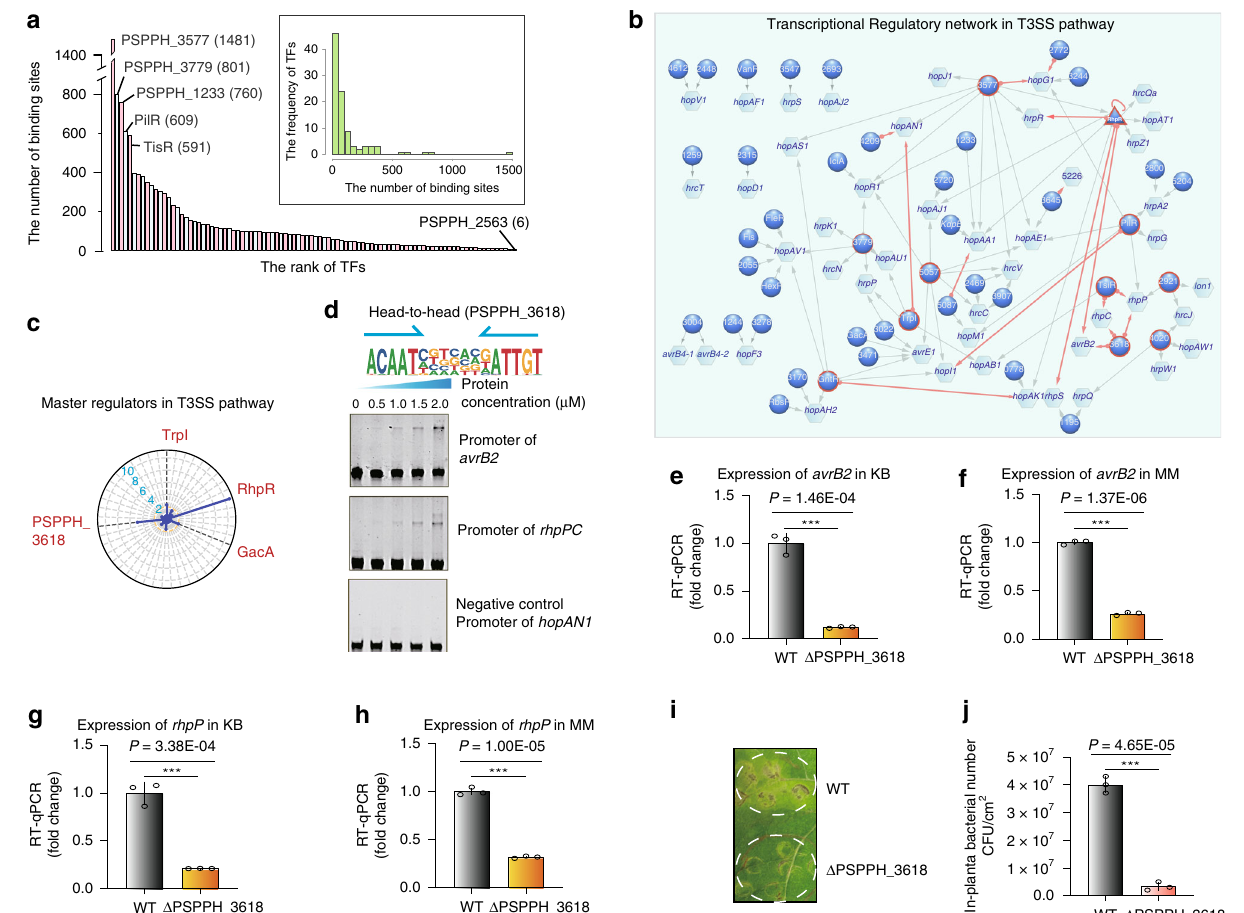
Fig. 3 Transcriptional regulation in the T3SS pathway. a Bar chart shows the distribution on the number of the putative binding sites per TF. Note that most of TFs target fewer than 200 genes with fi ve TFs exceptional bind more than 500 sites in the genome. b Network illustrates the regulatory relationship between TFs and their target genes in the T3SS pathway. Circles indicate TF proteins, hexagons indicate target genes, and the triangle represents the TF with auto-regulatory activity. TFs that can regulate more than two target genes are highlighted by the red edges. Red arrows show the putative binding sites located in the promoters of the target genes, while gray arrows show the putative binding sites located in the target gene bodies. The TFs without names are named with their locus tag omitting PSPPH_. c Radar plot shows the putative master regulators identi fi ed in the T3SS pathway. Each radiation line represents a TF, and the radial length of thick colored line is − log10 ( P value), representing the signi fi cance of the enrichment of the TF targets within T3SS-associated genes. The names of master regulators are marked in red-type face. d The head-to-head binding motif of PSPPH_3618 (upper) and the validation of the putative binding sites of PSPPH_3618 by EMSA (lower). The validated binding sites were from the promoters of the rhpPC operon and avrB2 . The promoter of hopAN1 was negative control. e , f The expression of target gene avrB2 was measured in the WT and Δ PSPPH_3618 strains by RT-qPCR in KB and MM, respectively. P value is 1.460E-04 ( e ). P value is 1.373E-06 ( f ). g , h The expression of target gene rhpP was measured in the WT and Δ PSPPH_3618 strains by RT-qPCR in KB and MM, respectively. P value is 3.38E-04 ( g ). P value is 1.001E-05 ( h ). i Disease symptoms caused by either WT or Δ PSPPH_3618 strain, 10 5 CFU/ml bacteria of which were in fi ltrated into the primary leaves of the bean. Disease symptoms were photographed 6 days after inoculation. j Bacterial numbers were quanti fi ed 6 days after inoculation. P value is 4.650E-05 ( j ). Three independent replicates were performed. Statistic P values by two-tailed Student ’ s t test are shown. **P < 0.01 and *** P < 0.001 ( g , h , j ). Error bars show standard deviations. TF transcription